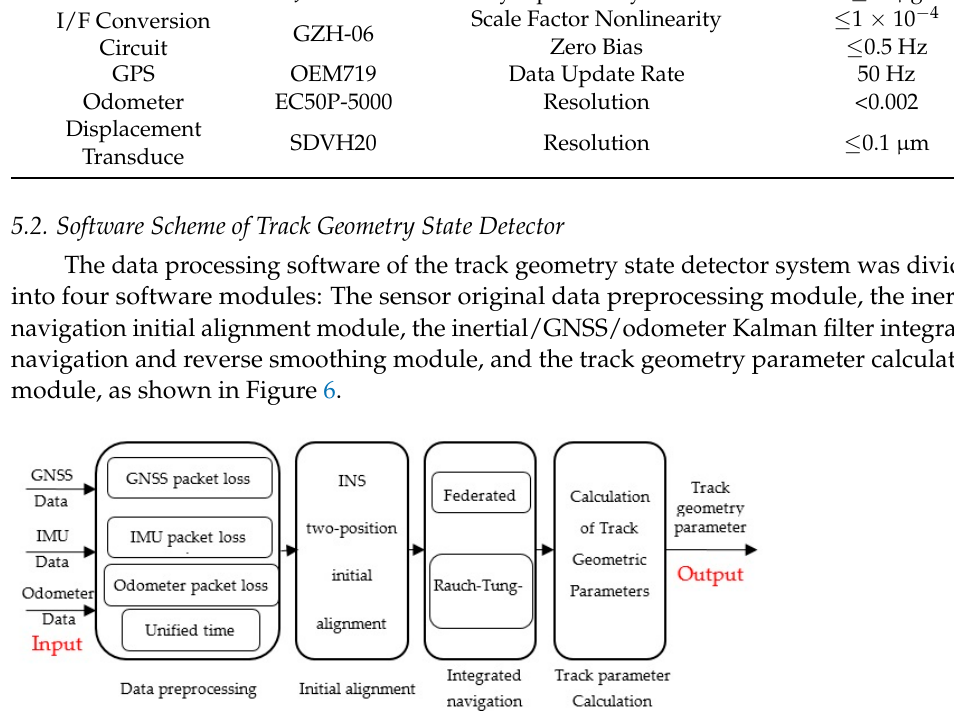
Figure 6. Design of data processing software for track inspector